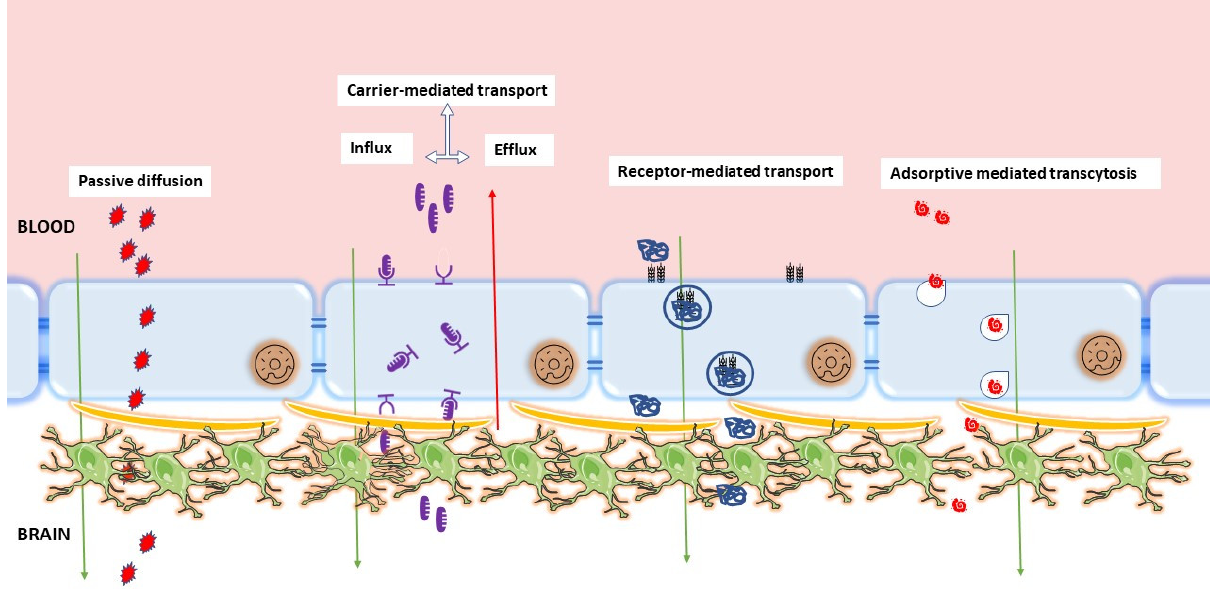
Figure 2. Major routes of transport across the BBB. The figure describes passive diffusion, carrier- mediated transport, receptor-mediated transport, and adsorptive-mediated transcytosis as major routes of transport across the endothelial layer of brain. The figure was inspired by Dwivedi, Divya, Kanu Megha, Ritwick Mishra, and Pravat K. Mandal. “Glutathione in brain: overview of its conformations, functions, biochemical characteristics, quantitation and potential therapeutic role in brain disorders”. Neurochem. Res. 2020 , 45 , 1461–1480 [37].